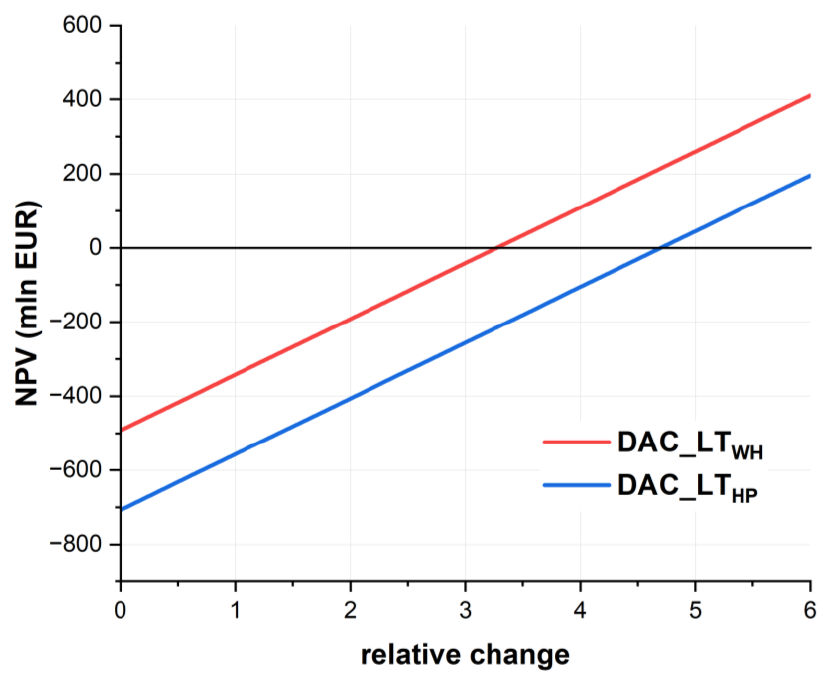
Figure 8. Sensitivity analysis for DAC low-temperature solid sorbent installations.